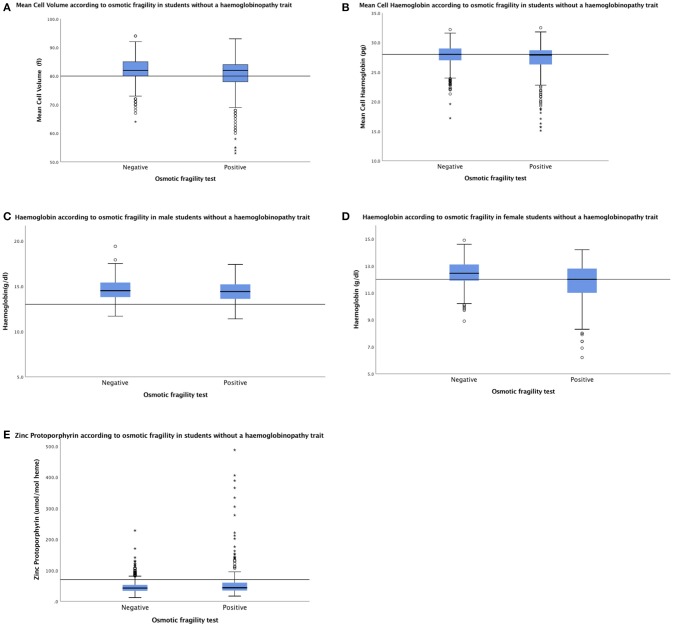
Median (IQR) MCV (A) and MCH (B) were similar in 235 students with an unexplained positive OF result and 1,005 students with a true negative OF result: 82.0 fl (77.0–84.0) and 27.8 pg (25.7–28.6) vs. 82.0fl (80.0–85.0) and 28.0 (26.9–29.0), respectively. Median (IQR) Hb was 14.4 g/dl (13.6–15.2) and 12.0 g/dl (10.9–12.8) in 96 males (C) and 139 females (D), respectively, with an unexplained positive OF result vs. 14.5 g/dl (13.8–15.4) and 12.5 g/dl (11.9–13.1) in 383 males and 622 females with a true negative OF result. Median (IQR) ZPP was similar in 235 students with an unexplained positive OF result and 1,005 with a true negative OF result; 44 μmol/mol heme (add IQR) and 43 μmol/mol heme (add IQR), respectively (E). Horizontal lines inside the box show the median value, box length is the interquartile range and whiskers show the range, excluding outliers. Outlying values 1.5–3, or > 3 box lengths from the upper and lower edge of the box are shown as open circles and stars, respectively. Reference lines shows the lower limit of the normal range for MCV, MCH, and Hb and the upper limit of the normal range for ZPP.